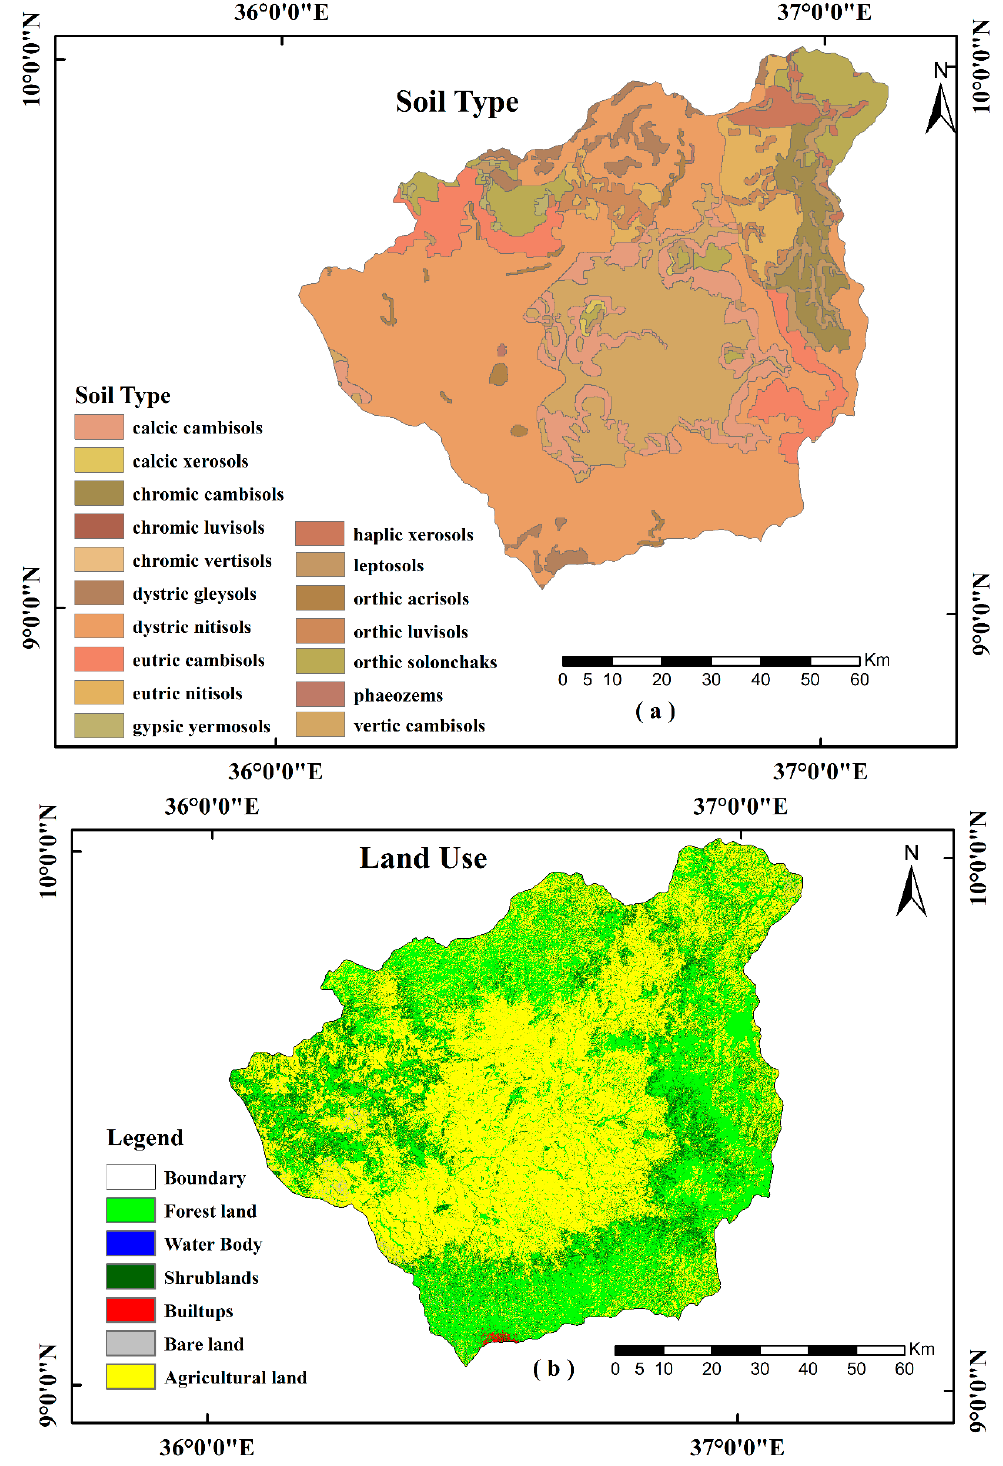
Figure 2. Soil type ( top a ) and land use land cover ( bottom b ) of the study area.